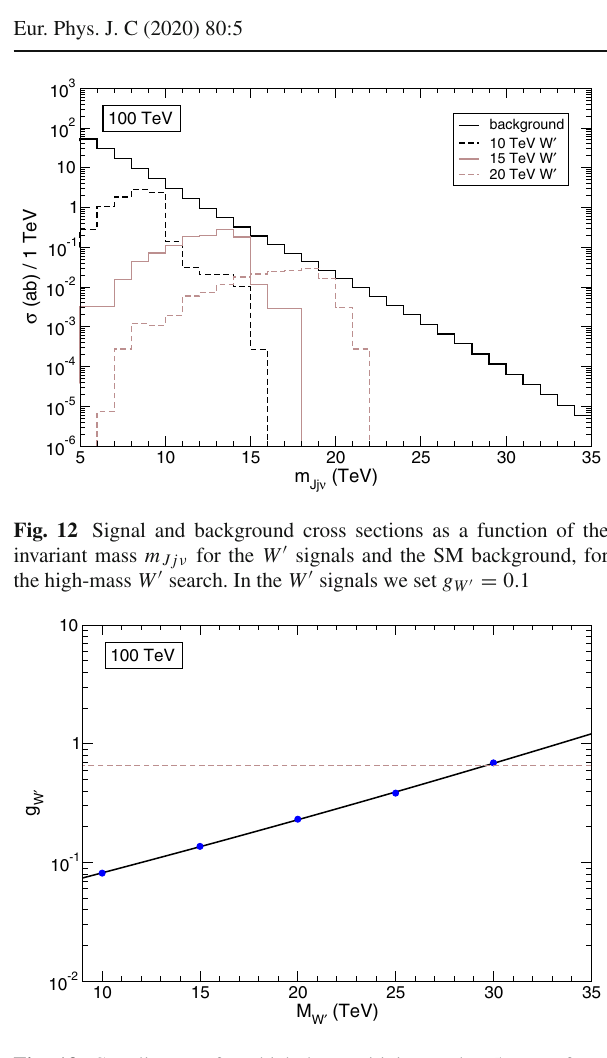
Fig. 13 Coupling g W (cid:2) for which the sensitivity reaches 5 σ , as a func- tion of the W (cid:2) mass. The blue dots indicate the results from the simu- lation, and the solid line the fit in Eq. (18). The horizontal dashed line corresponds to g W (cid:2) = g The reconstructed W (cid:2) mass distribution for the